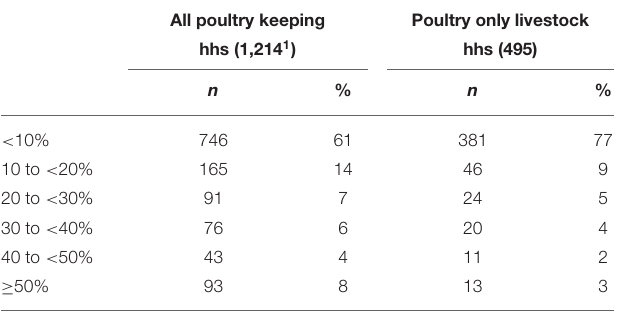
TABLE 5 | Frequency distribution of the proportion of birds lost to disease for flocks of 1–20 and of 21–50 birds. Share 1 of